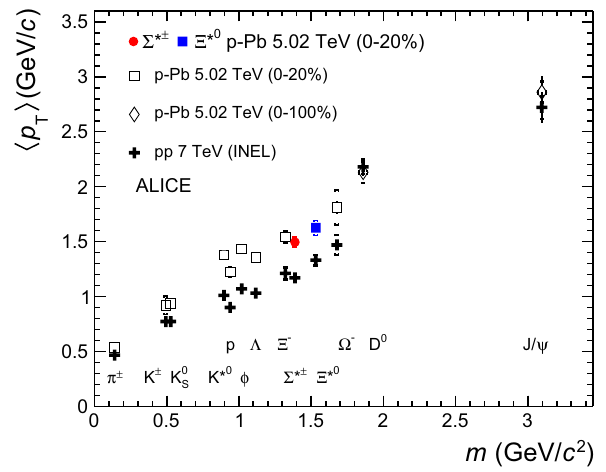
Fig. 7 Mass dependence of the mean transverse momenta of iden- tified particles for the 0–20% V0A multiplicity class and with √ − 0 . 5 < y < 0 in p–Pb collisions at s NN = 5 . 02 TeV [10, √ CMS s = 7 TeV [17] 24], and in minimum-bias pp collisions at with | y CMS | < 0 . 5. Additionally, D 0 and J / ψ results are plot- ted. The D 0 and J / ψ were measured in different rapidity ranges: | y | < 0 . 5 [34] ( | y | < 0 . 9 [35]) for D 0 ( J / ψ ) in pp and CMS CMS